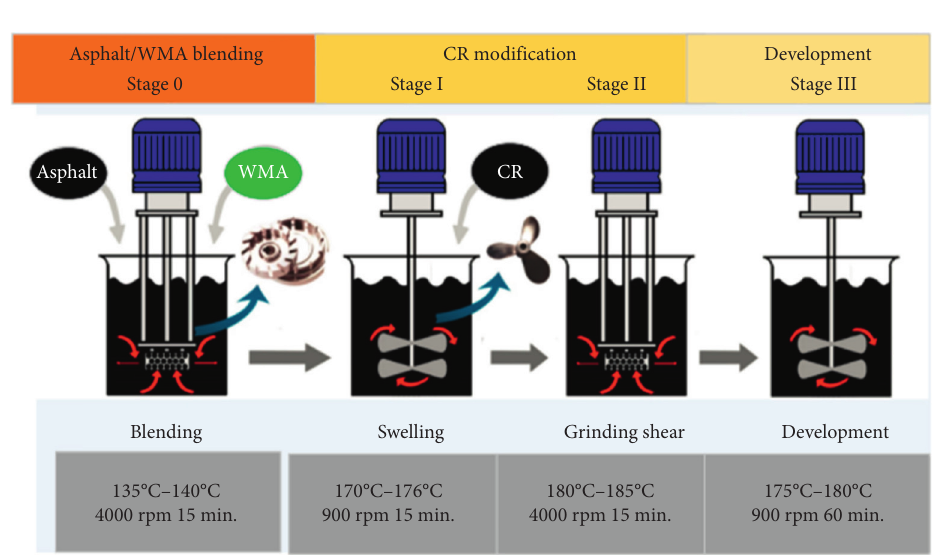
Figure 2: CRM warm mix asphalt modification procedure utilized herein.